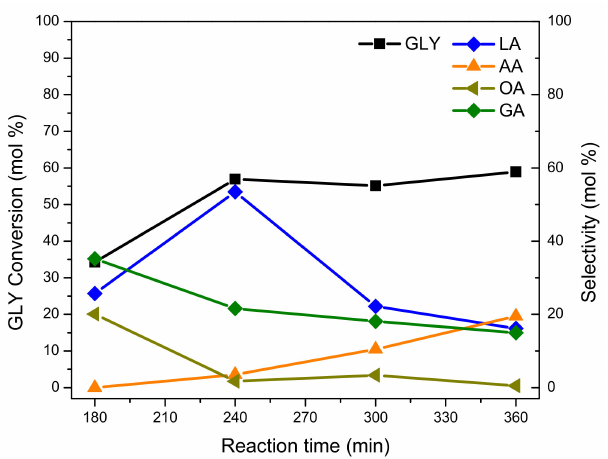
Figure 10. GLY conversion and oxidation products’ selectivity vs. reaction time in GLY oxidation of the Pt-ZSM-11